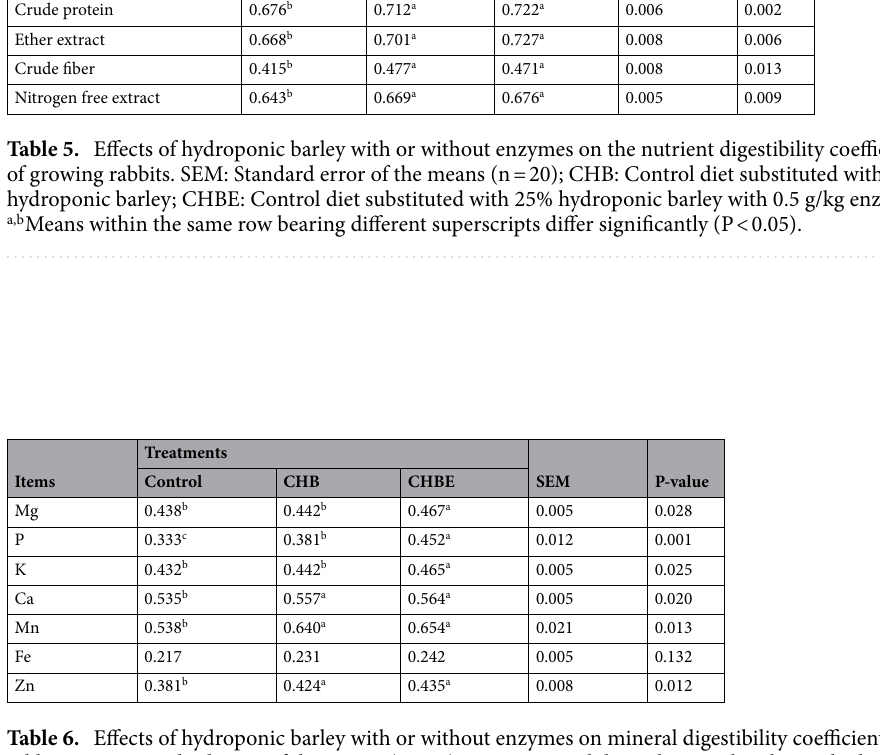
Table 6. Effects of hydroponic barley with or without enzymes on mineral digestibility coefficient of growing rabbits. SEM: Standard error of the means (n = 20); CHB: Control diet substituted with 25% hydroponic barley; CHBE: Control diet substituted with 25% hydroponic barley with 0.5 g/kg enzymes. a– c Means within the same row bearing different superscripts differ significantly (P <